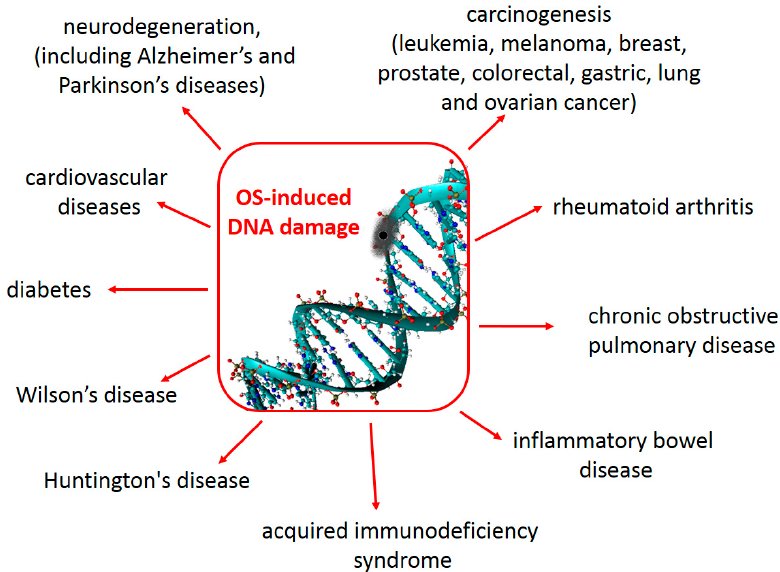
Figure 1. Some consequences to human health, derived from oxidative damage to DNA. See text for details and references.